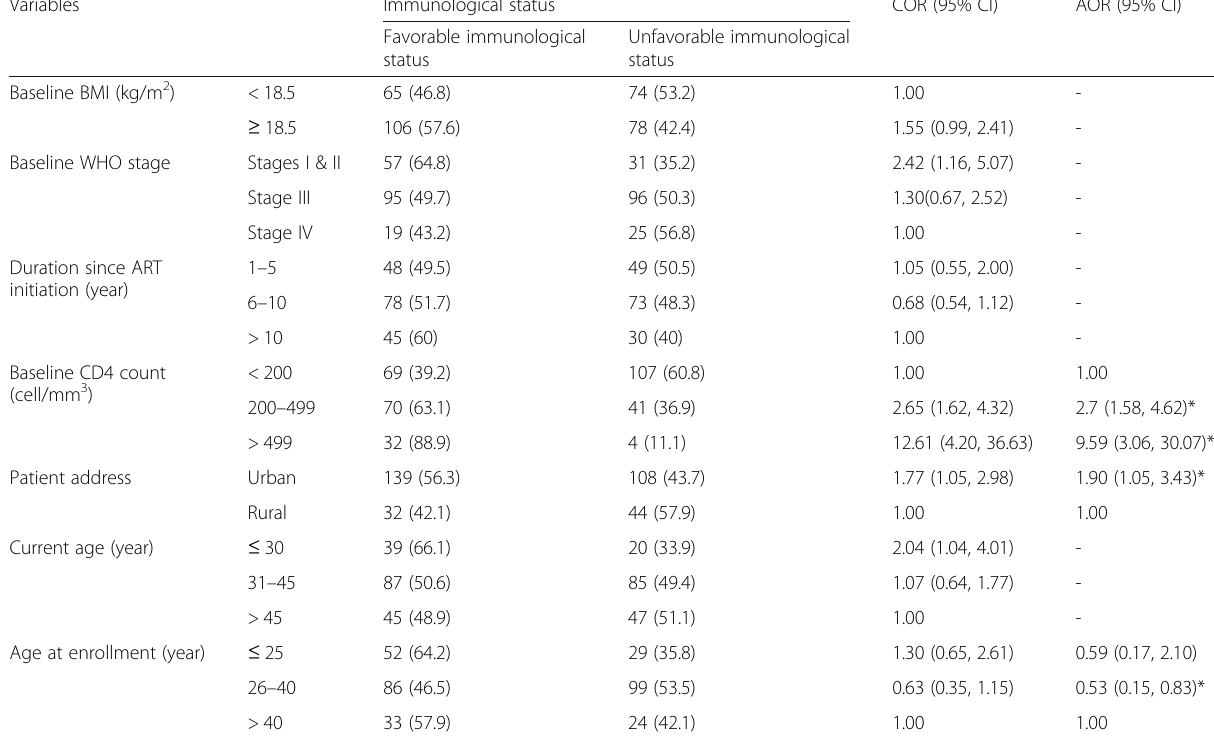
COR crude odds ratio, AOR adjusted odds ratio; ART antiretroviral therapy, CD4 cluster of differentiation 4, BMI body mass index, WHO World health Organization, HAART Highly active antiretroviral therapy *Significantly associated at P value